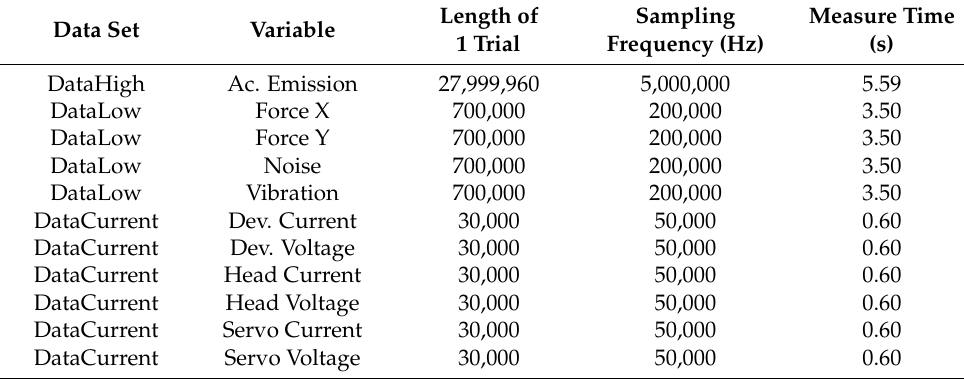
Figure 2. The structure of the data sets used in analysis. Table 1. The structure of the data variables in data